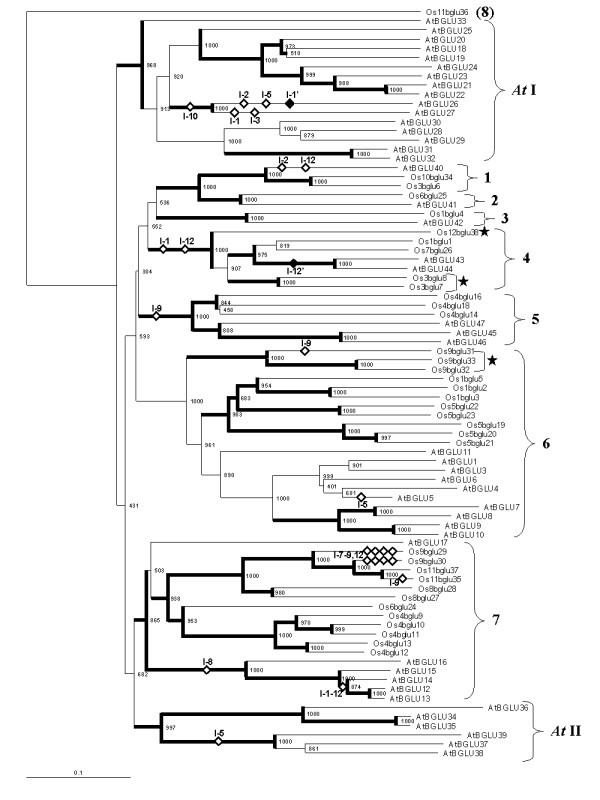
Phylogenetic tree of predicted protein sequences of rice and Arabidopsis Glycosyl Hydrolase Family 1 genes. The tree was derived by the Neighbor-joining method from the protein sequence alignment in the Supplementary Data Additional File 2 made with Clustalx with default settings, followed by manual adjustment. Large gap regions were removed for the tree calculation. The tree is drawn as an unrooted tree, but is rooted by the outgroup, Os11bglu36, for the other sequences. The bootstrap values are shown at the nodes. The clusters supported by a maximum parsimony analysis are shown as bold lines, and the loss and gain of introns are shown as open and closed diamonds, respectively. The 7 clusters that contain both Arabidopsis and rice sequences that are clearly more closely related to each other than to other Arabidopsis or rice sequences outside the cluster are numbered 1–7, while the outgroup cluster for which the Arabidopsis orthologue is not shown in numbered (8). Two Arabidopsis clusters that are more distantly diverged from the clusters containing both rice and Arabidopsis are numbered At I and At II, while rice genes and groups of genes that appear to have diverged before subclusters containing both rice and Arabidopsis are marked with stars.